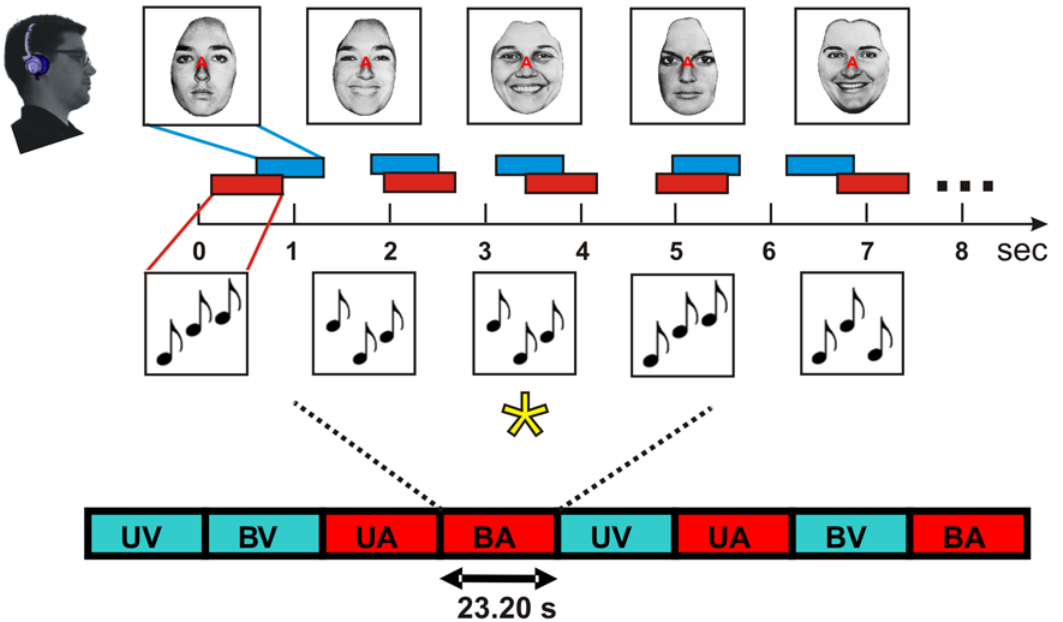
Figure 2. Intermodal selective attention paradigm. Stimuli were presented in blocks lasting 23.2 s. Auditory stimuli were three-tone patterns varying in intensity (90 or 70 dB SPL), location (left ear, right ear or binaural) and frequency (center frequency=225 Hz, 900 Hz, or 3600 Hz) in different blocks. Visual stimuli were pictures of faces or words. Subjects focused attention on the modality cued by the letter at fixation (e.g., ‘‘A’’ top) and performed difficult one-back matching task matching repeated tone patterns during auditory attention ( target=asterisk). Auditory and visual stimuli were presented with randomized asynchronous onsets to minimize multimodal integration. Attend-auditory (red) and attend-visual (blue) blocks occurred in constrained random order. UV=unimodal visual. UA=unimodal auditory. BV=bimodal, visual attention. BA=bimodal, auditory attention.